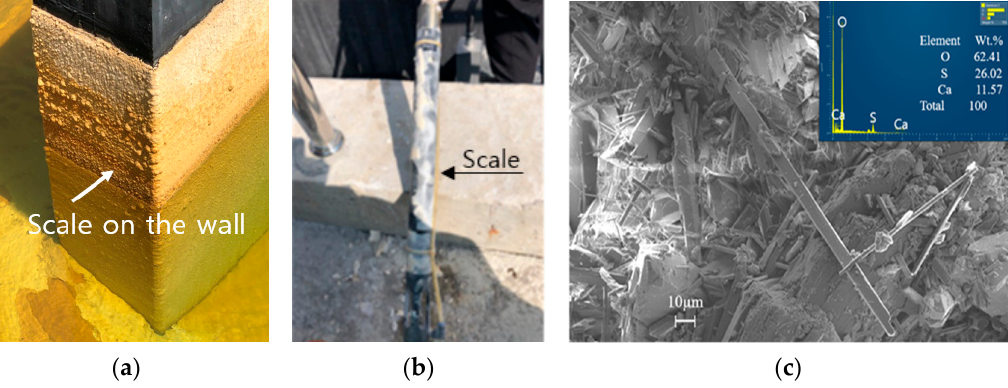
Figure 4. ( a ) Scale on the wall of the concrete sedimentation basin and ( b ) on the pH electrode. ( c ) SEM/EDS Image of scale obtained from the pH electrode.